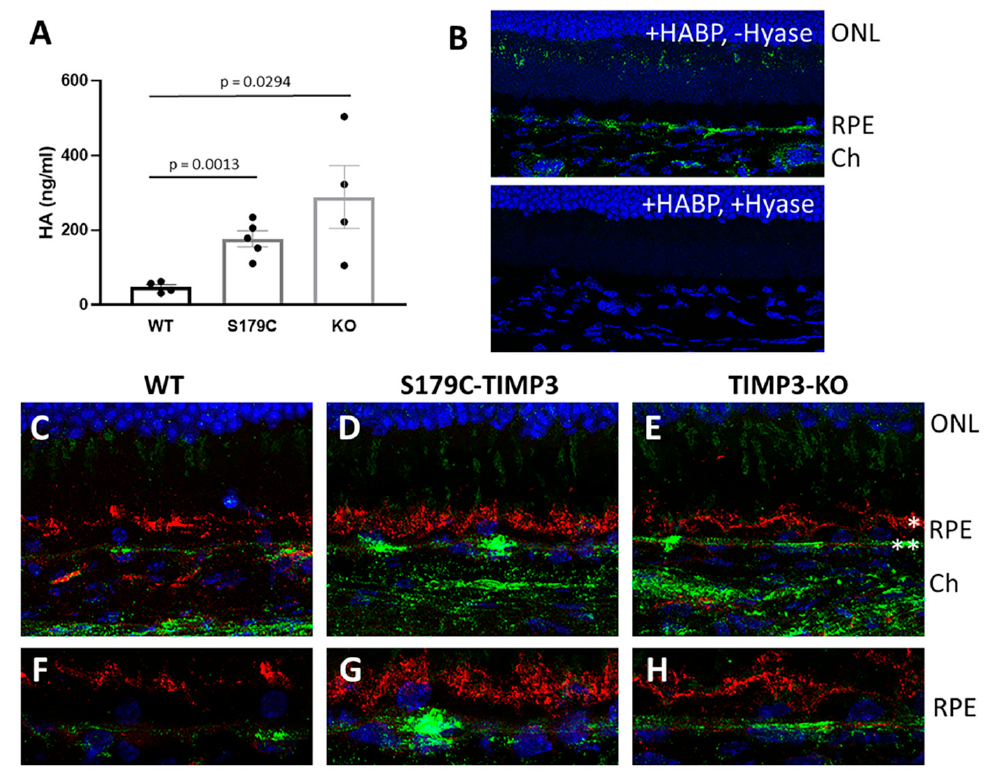
Figure 2. HA is increased in circulation and in the RPE and choroid in mouse models of Sorsby’s fundus dystrophy. ( A ) HA was increased in plasma from S179C-TIMP3 knockin mice (Timp3 S179C6 / S179C ) and TIMP3-KO (Timp3 - / - ) mice compared to wild-type (WT) littermates. (n ≥ 5). Data are presented as mean ± SEM. ( B ) Mouse retina sections stained with biotinylated HA binding protein (HABP) in the absence (upper panel) or presence (lower panel) of hyaluronidase to detect HA. HABP staining is specific for HA as shown by the absence of staining in sections treated with hyaluronidase (lower panel). Green: HA; blue: DAPI. ( C – H ) Representative images of HA staining of mouse sections from wild-type (WT) mice ( C , F ), S179C-TIMP3 mutant mice ( D , G ) and TIMP3-KO mice ( E , H ). HA is increased in the RPE and choroid of S179C-TIMP3 ( D ) and TIMP3-KO ( E ) mice compared to wild-type (WT) littermate controls ( C ). HA (green) is predominantly localized to the basal surface of the RPE (**) ( F – H ) and not to the apical surface (*) as shown by co-staining with ezrin, a marker for the apical microvilli of RPE (red). 40 × images ( C – E ); 63 × images ( F – H ). n ≥ 3 for all immunohistochemistry data.